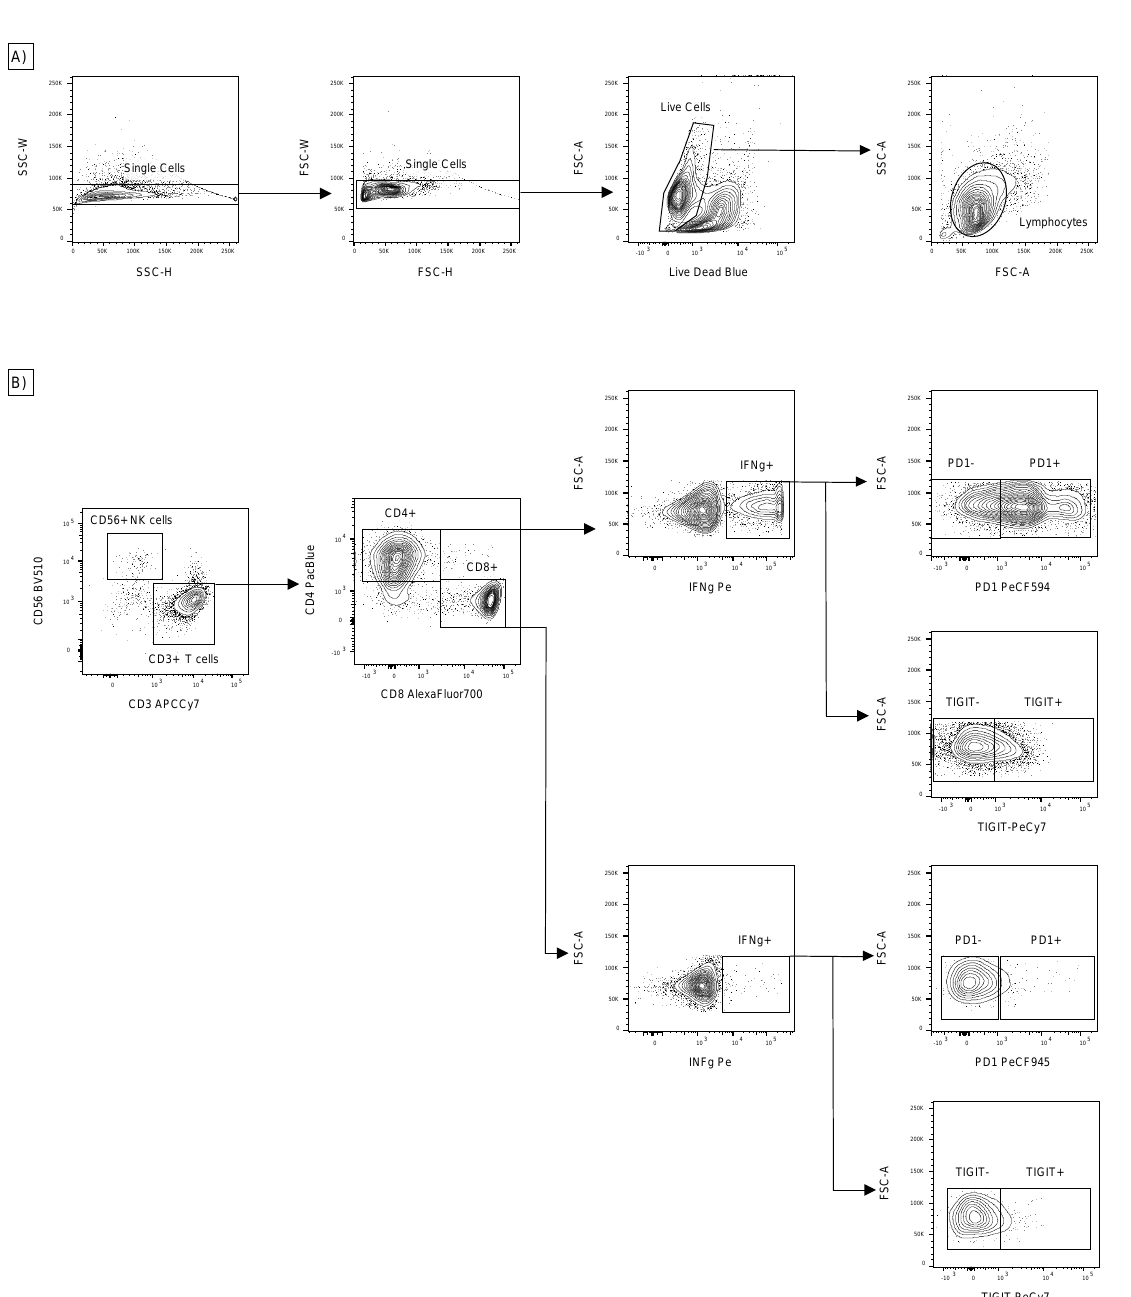
Figure 1. Gating strategy for IC-FACS analysis. ( A ) Doublets, dead cells and debris were removed from the samples and lymphocytes were gated based on SSC and FSC. ( B ) NK cells and T-cells were separated using CD56 and CD3. The expression of IFN γ by CD4 and CD8 T-cells was subsequently evaluated. The presence of PD1 and TIGIT exhaustion markers was detected on the on CD4 + IFN γ + and CD8 + IFNg +